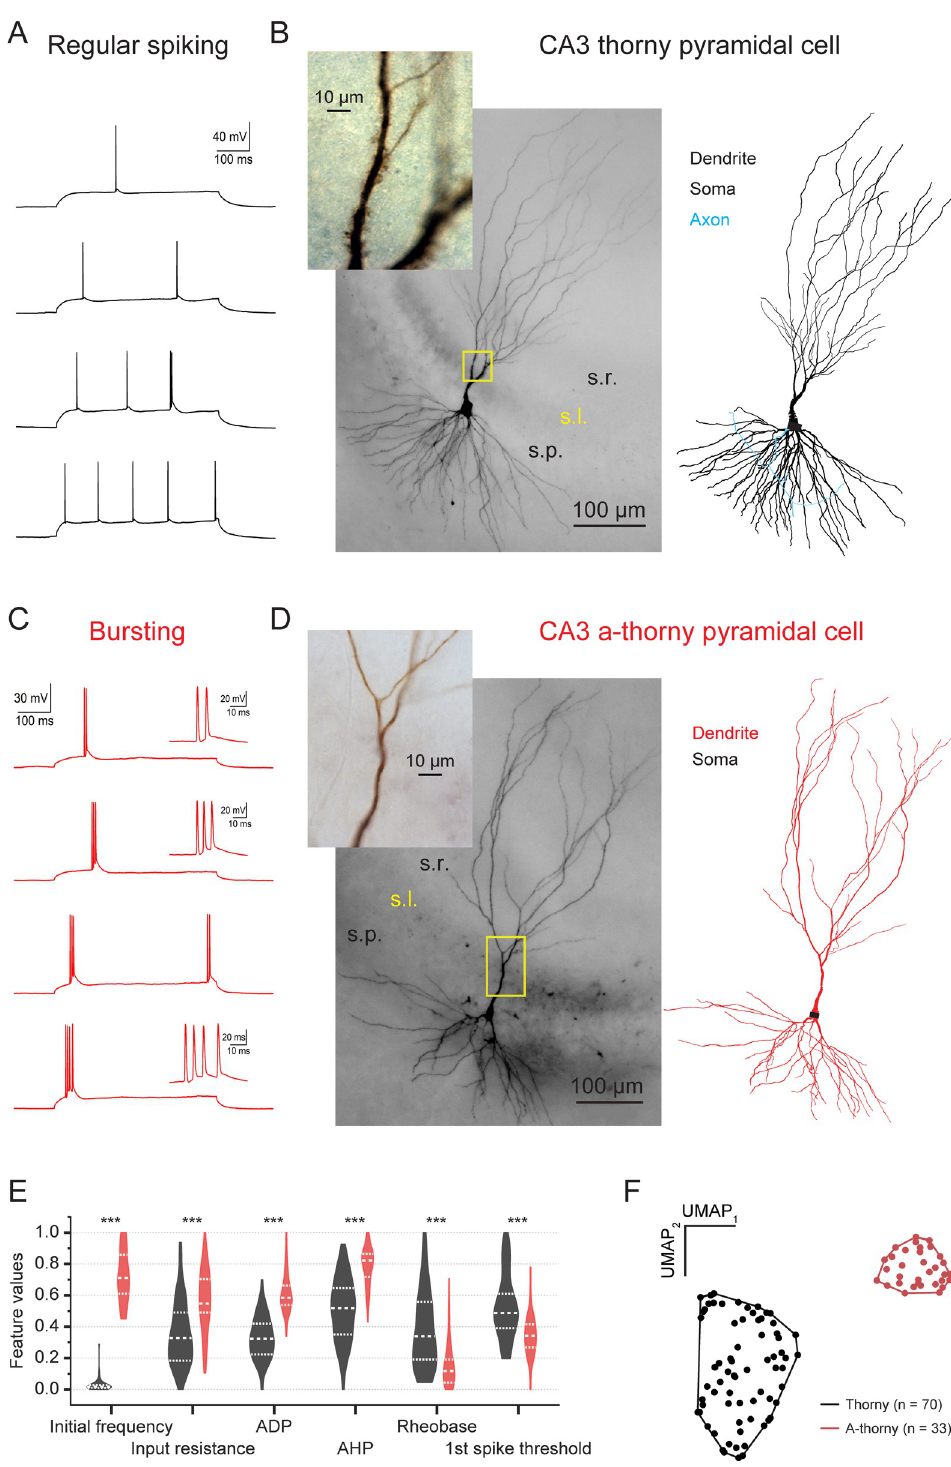
Fig 1. Physiological and morphological phenotypes of CA3 pyramidal neurons. (A) Representative traces from a series of somatic current injections where a regular spiking firing phenotype was observed. (B) Left, biocytin staining of the cell recorded in (A) where a full-scale view of the dendrites and their distribution across the laminar structure of the CA3 region is shown. Inset, high magnification view of the proximal apical dendrite where prominent complex spiny structures known as thorny excrescences can be observed. Right, 3D morphological reconstruction of the biocytin-